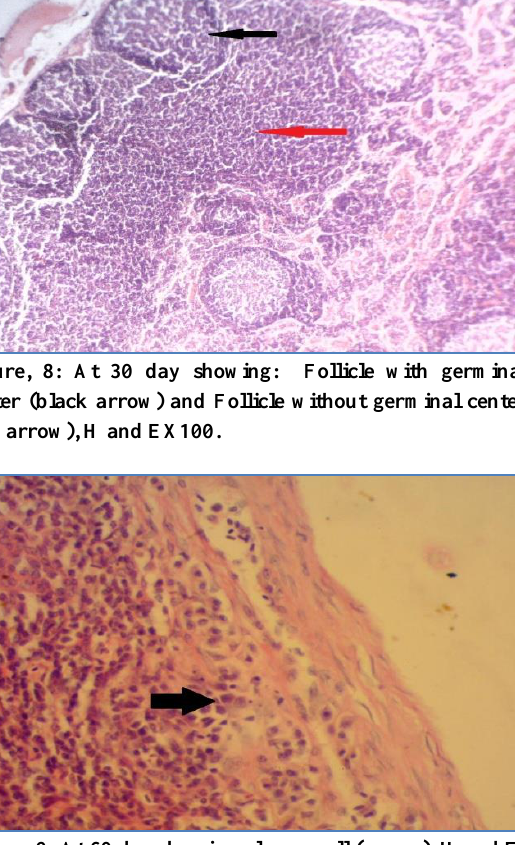
Figure, 9: At 60 day showing plasma cell (arrow), H and E